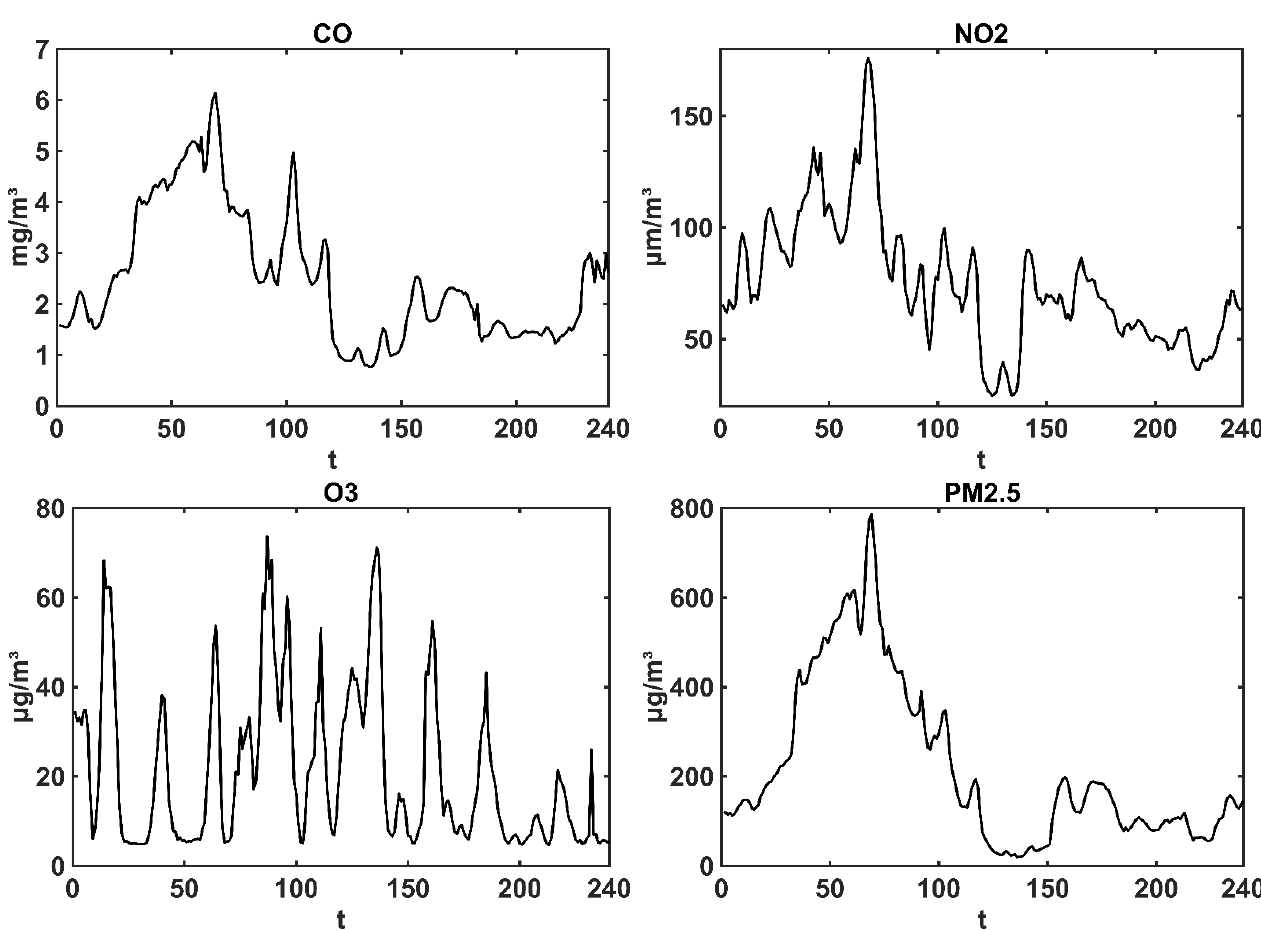
Figure 2. Hourly average NO 2 , CO, O 3 , PM 10 , PM 2.5 and SO 2 data of Zhengzhou over the period from 24:00 17 December 2016 to 23:00 26 December 2016 (240 h). 3. Introduction to CDFA Method and Multifractal Contribution Sources 3.1. CDFA (Coupling Detrended Fluctuation Analysis) Method To reveal the multi fractal characteristics of CO, NO 2 , O 3 , PM 10 , PM 2.5 and SO 2 in Zhengzhou, we use the CDFA approach proposed by Hedayatifar et al. [37]. The method is well suited for testing the mutual coupling of over two series, and it can be described as follows: 1. Series containing n time series { 1 m x ,…, j m x ,…, Cumulative